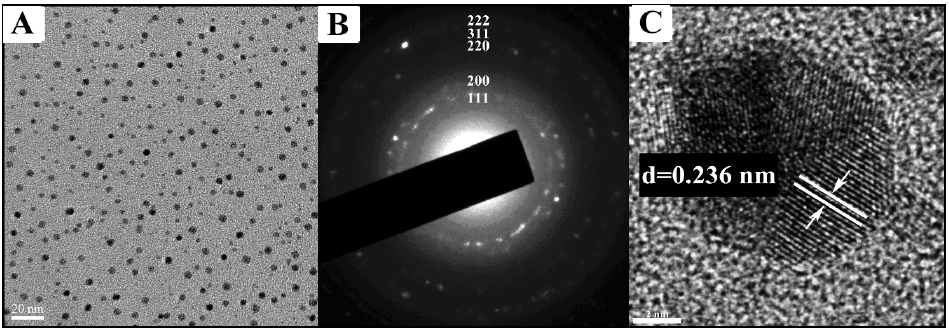
Figure 6. ( A ) TEM image, ( B ) selected area electron diffraction pattern and ( C ) HRTEM image and of PFcMAss-AuNPs.